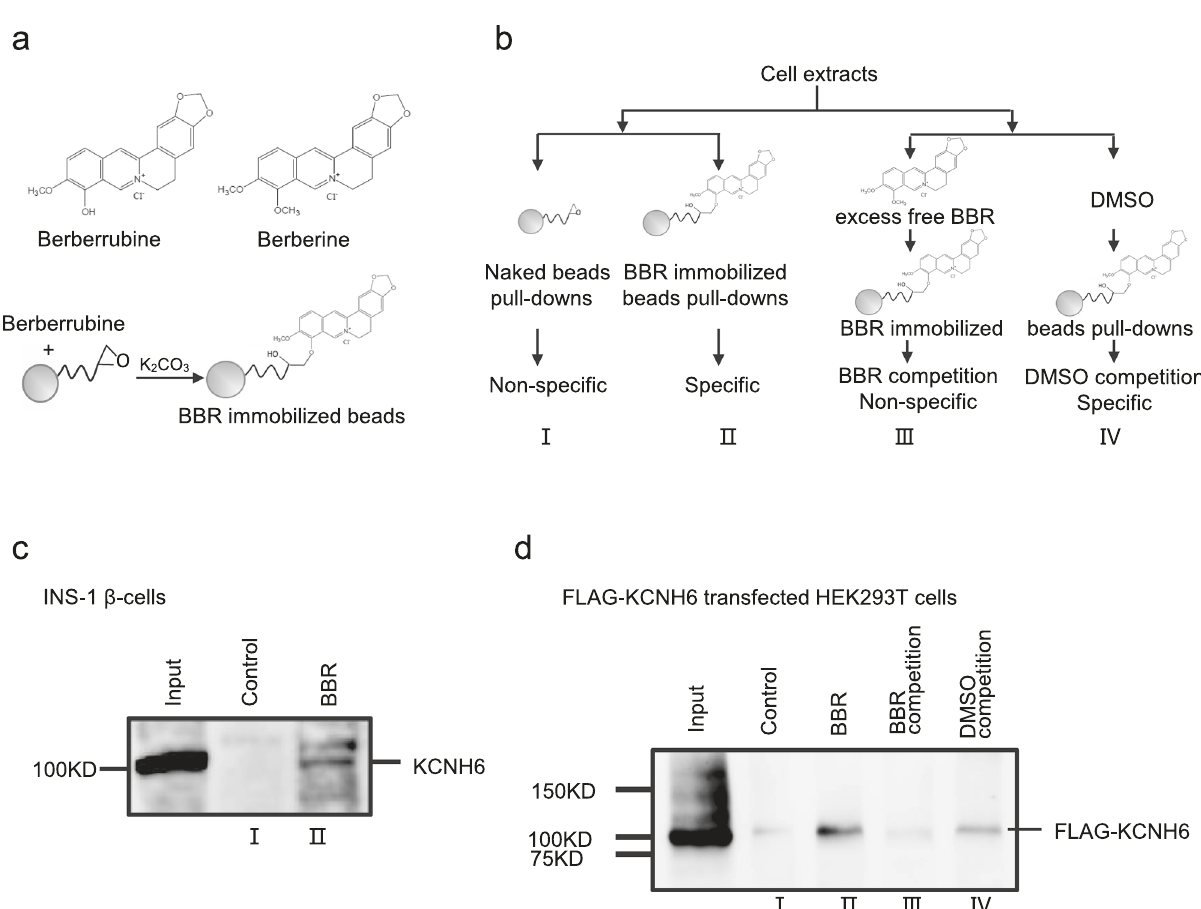
Fig. 3 BBR targets KCNH6 channel proteins on islet β -cells. a The active derivative of BBR, berberrubine, was immobilized on high-performance af fi nity beads. b Schematic of the experimental design. BBR-binding proteins were puri fi ed from cell extracts using different beads, as indicated. (I) Naked beads were used as a control; (II) BBR-immobilized beads were used to pull down BBR-binding proteins in the eluate; (III) 1 mM BBR was added to the extracts before the incubation with BBR-immobilized beads to reduce the yield of speci fi c binding proteins; (IV) the same amount of vehicle (DMSO) was added to cell extracts before the incubation with the beads as a control for (III). Bound proteins were eluted and subjected to western blot analyses. c BBR-binding proteins from INS-1 β -cell extracts were analyzed with western blotting using an anti-KCNH6 antibody. A representative immunoblot from three different experiments is shown. d KCNH6-null human embryonic kidney 293 T (HEK293T) cells were transfected with plasmids encoding FLAG-tagged human KCNH6 . BBR-binding proteins from transfected HEK293T cell extracts were analyzed with western blotting using an anti-FLAG antibody. A